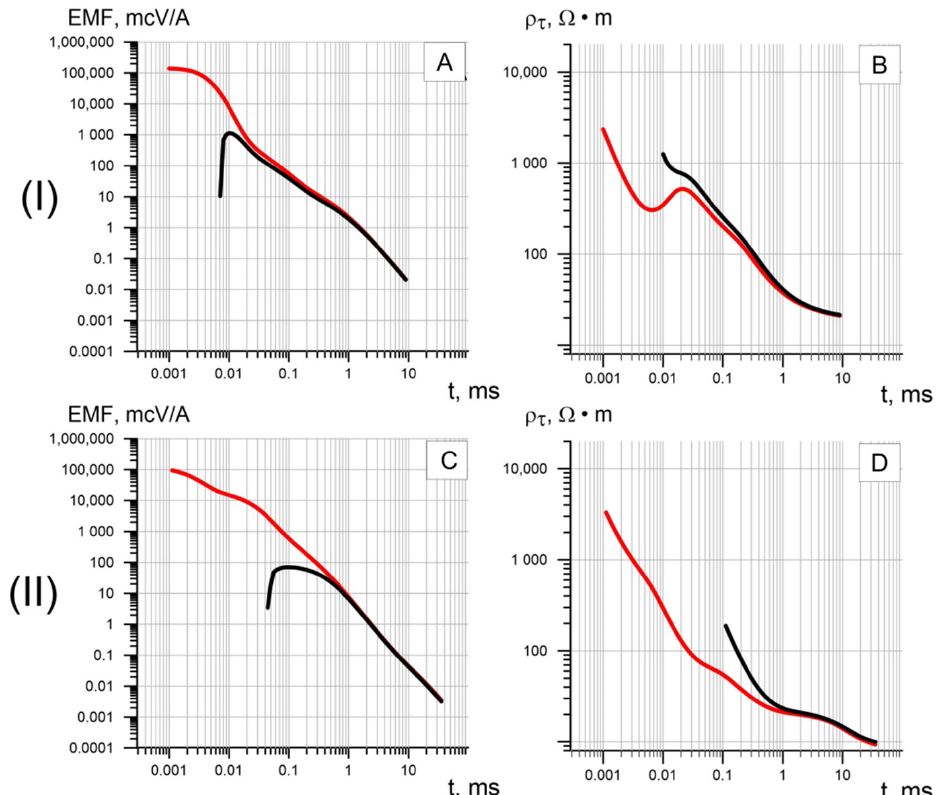
Figure 4. sTEM curves collected in the Site 1 ( I ) and Site 2 ( II ) areas, with 100 m offset receiver loop (black) and zero-offset receiver loop (red) arrays. ( A , C )—time-dependent voltage decay; ( B , D )—apparent resistivity curve.